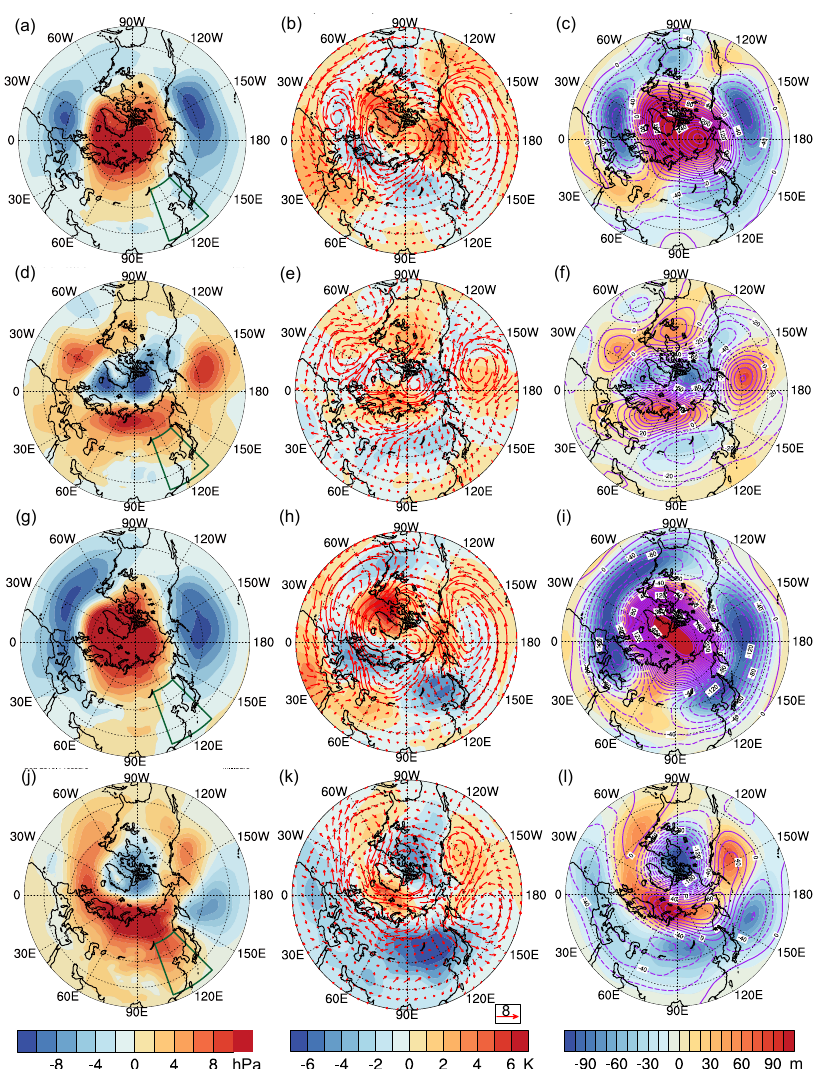
Figure 5. Composite differences between pronounced negative and positive AO in early-winter months in ( a ) sea level pressure (SLP), ( b ) in 2m temperature and 850hPa winds, and ( c ) in 500hPa (filled color) and 100hPa (contours) geopotential heights; ( d – f ) that for the difference between pronounced negative and positive DET_CAI in early-winter months, respectively; and ( g – l ) that for late-winter months,